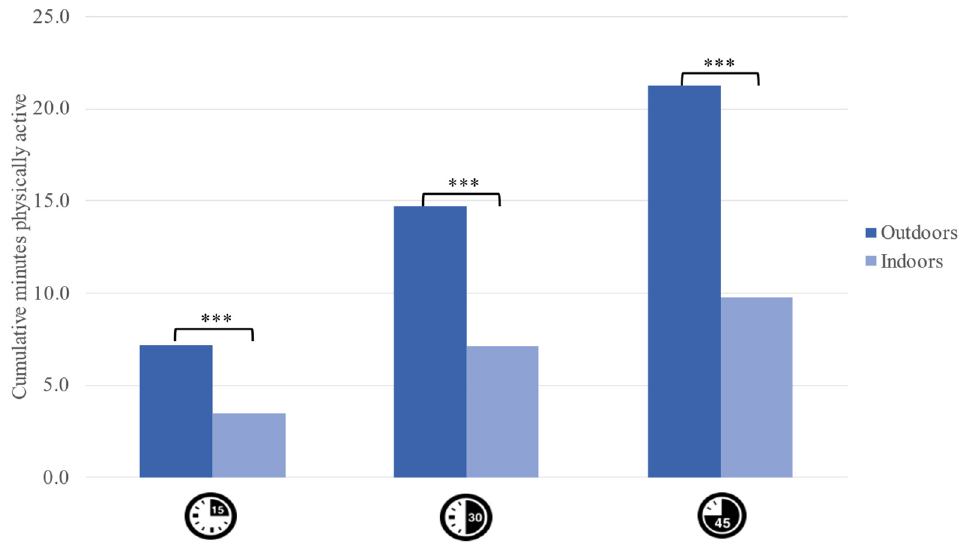
Figure 2. Mean cumulative minutes of physical activity in outdoor play versus indoor by 15 Min intervals. Note: *** p < 0.001 .